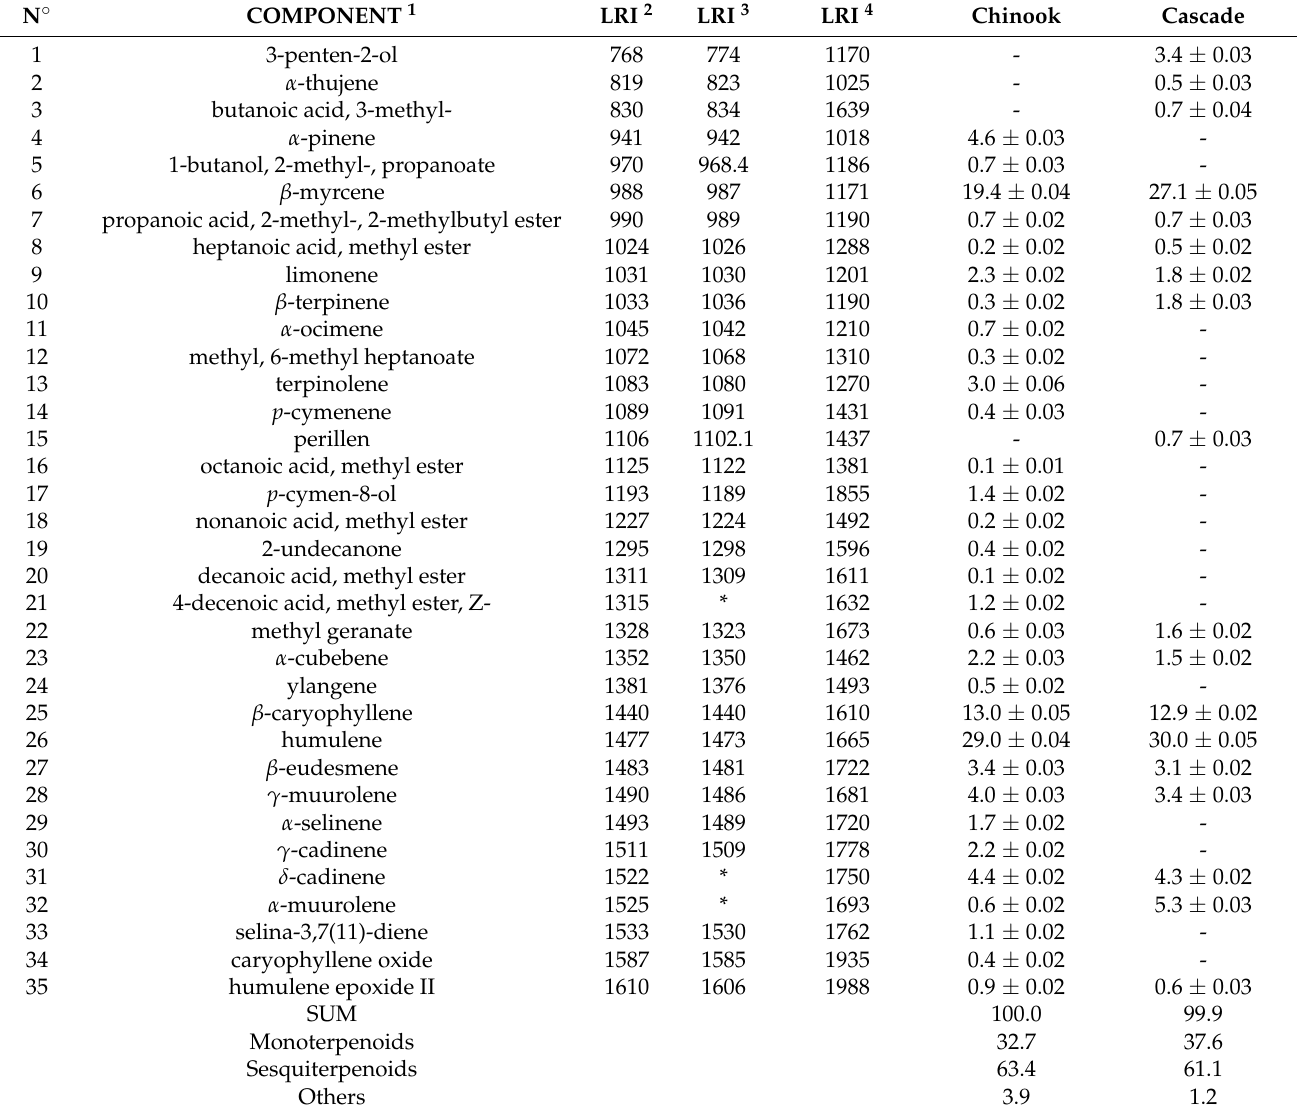
Table 1. Chemical volatile composition (percentage mean value ± standard deviation) of the hop